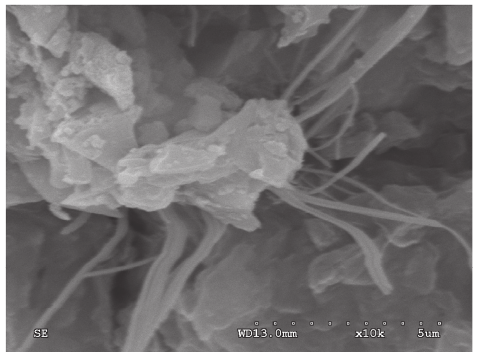
Figure 15: The soil of curing 28d and being magnified 10000 times (2).